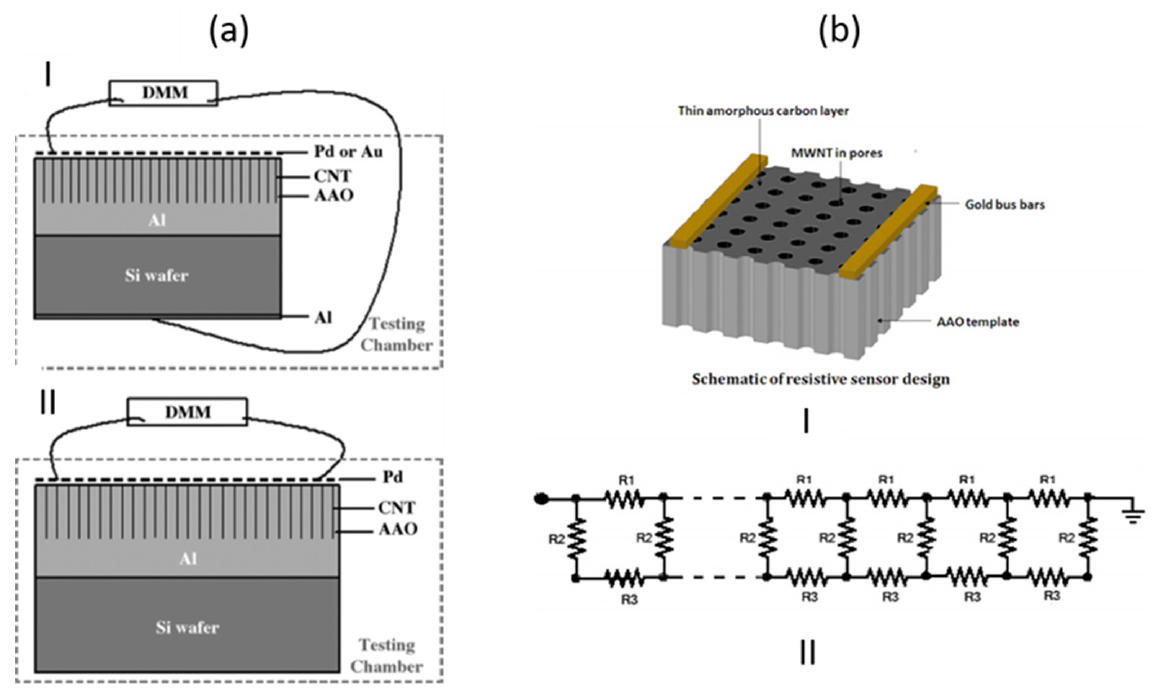
Figure 37. The different metal electrodes configurations were proposed to develop PAA/CNTs gas sensors. ( a ) Two different metal electrodes configuration have been proposed by Ding et al. [274], metal electrodes were deposited on the top PAA surface and on the Si wafer backside where the PAA was anodized. Reprinted with permission from Ref. [274]. Copyright © 2023 Elsevier Ltd. All rights reserved. ( b ) Two gold bars have been deposited as metal electrodes on the top surface, then, the amorphous carbon layer on the top surface electrically connects the CNTs grown inside the pores [282]. Reprinted and modified with permission from Ref. [282]. IOP Science Copyright © 2023.